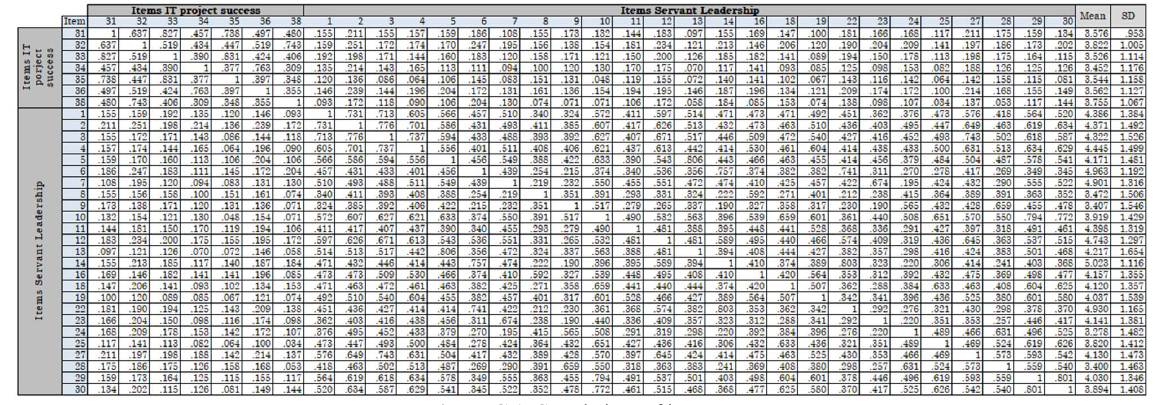
Figure C.1. Correlations of